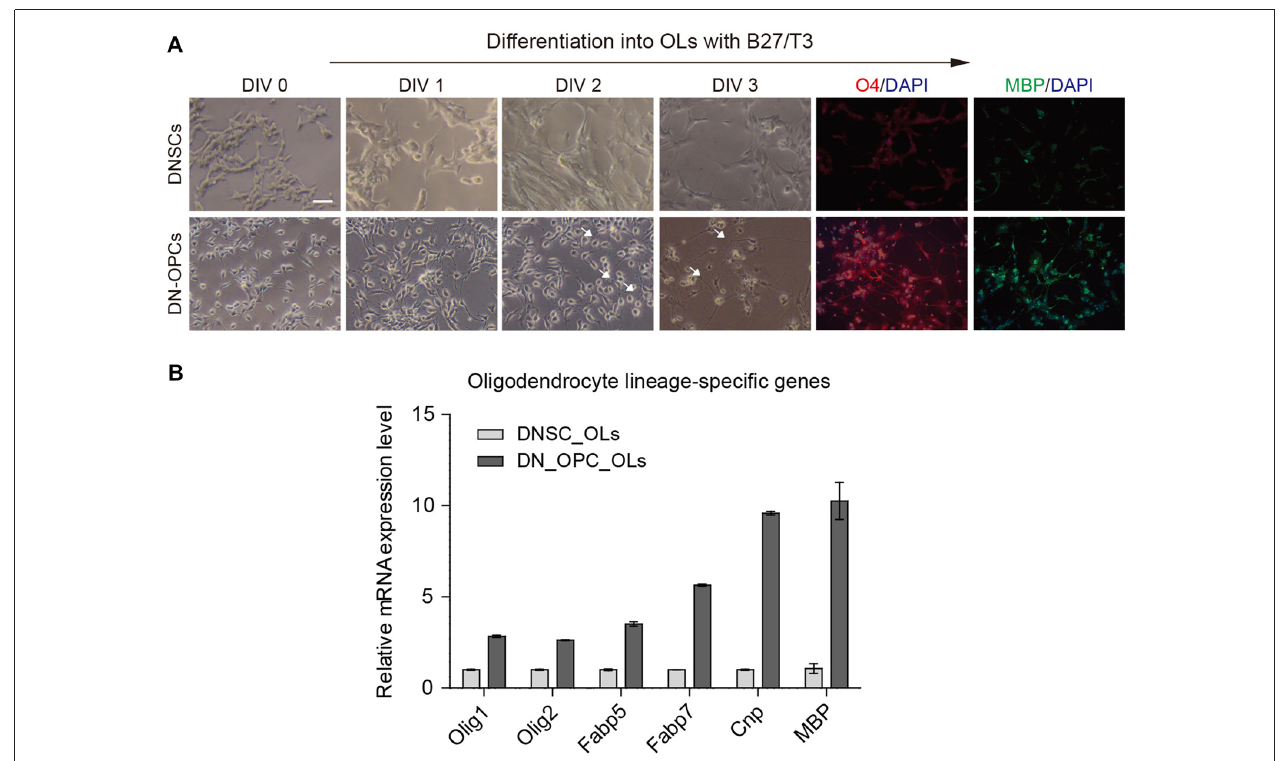
FIGURE 3 | Efficiency of differentiation into oligodendrocytes (OLs). (A) Difference of morphology during differentiation into OLs and immunocytochemistry. (B) Quantitative RT-PCR analysis. Glial related mRNA expression level between DNSC-derived OLs and DN-OPC-derived OLs. Graphs represent changes after normalization to DNSC-derived OLs. Data are present as the means ± SEM ( n = 3). Scale bar: 250 µ m. The white arrows indicate multiple